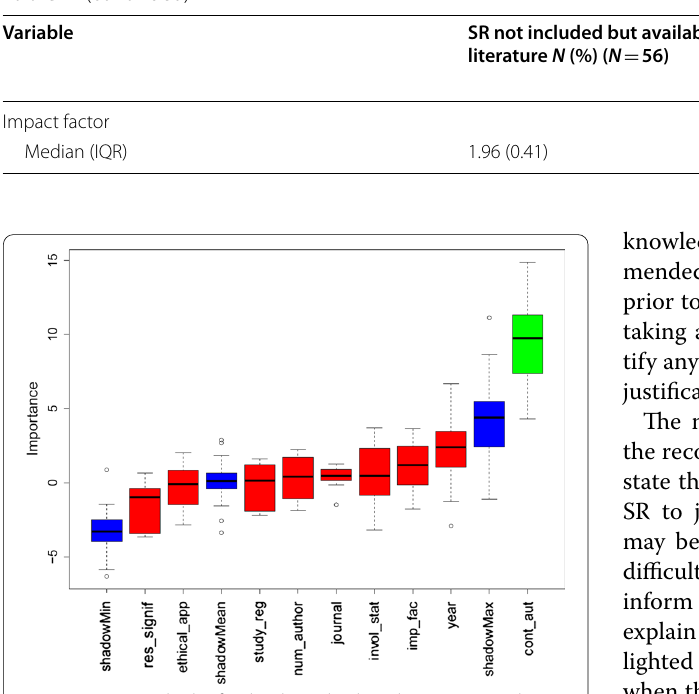
Fig. 2 Boruta result plot for the data. Blue boxplots correspond to minimal, average and maximum Z score (importance) of a shadow attribute. Red and green boxplots represent Z scores of, respectively, rejected and confirmed attributes